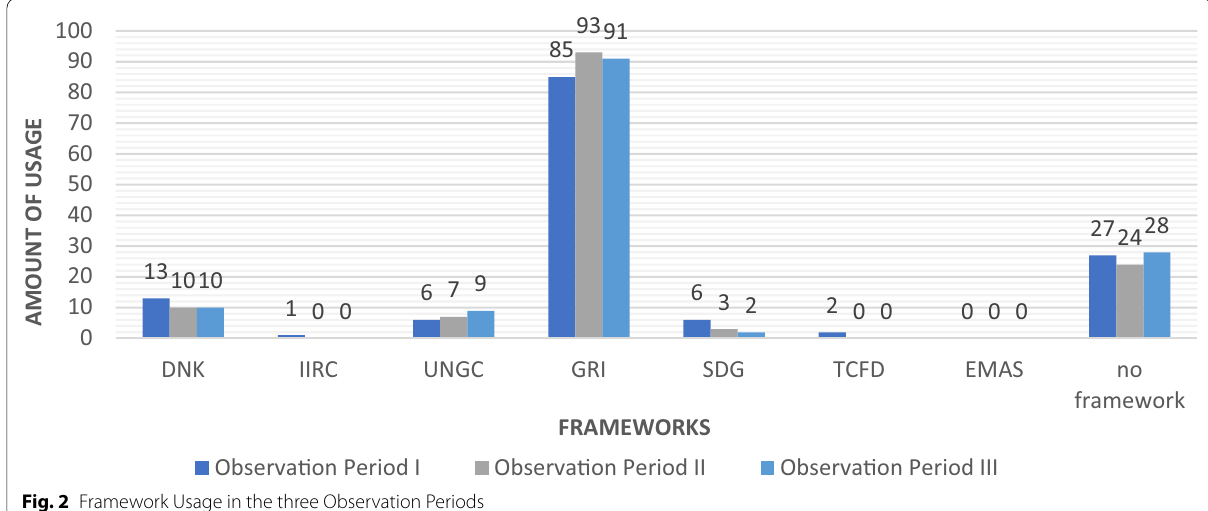
Fig. 2 Framework Usage in the three Observation